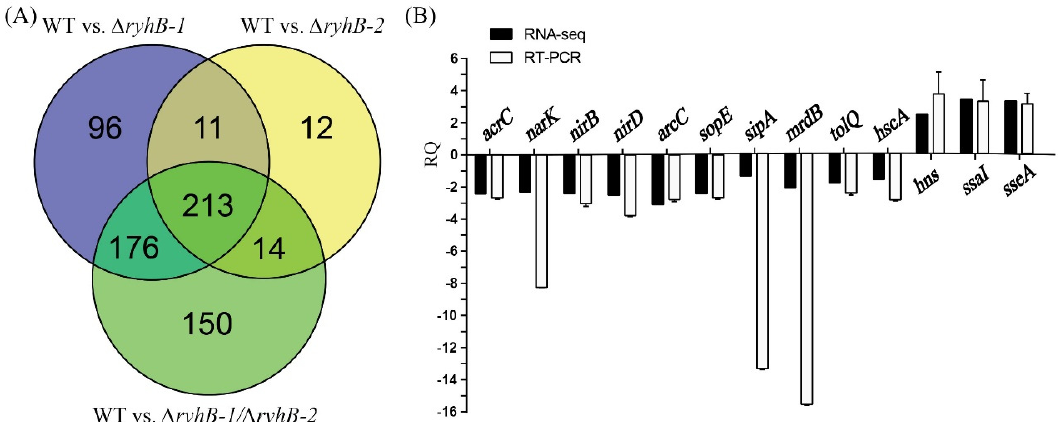
Figure 1. Analysis and verification of differentially expressed genes (DEGs) screened from RNA- seq data. ( A ) Venn diagrams were created using Venny (https://bioin- fogp.cnb.csic.es/tools/venny/index.html, accessed on 6 March 2019); ( B ) 13 DEGs that were ran- domly selected were verified by quantitative real-time PCR (qRT-PCR). RQ means relative quanti- fication values of gene expression in the ∆ ryhB − 1 ∆ ryhB − 2 mutant relative to that in the wild-type (WT)